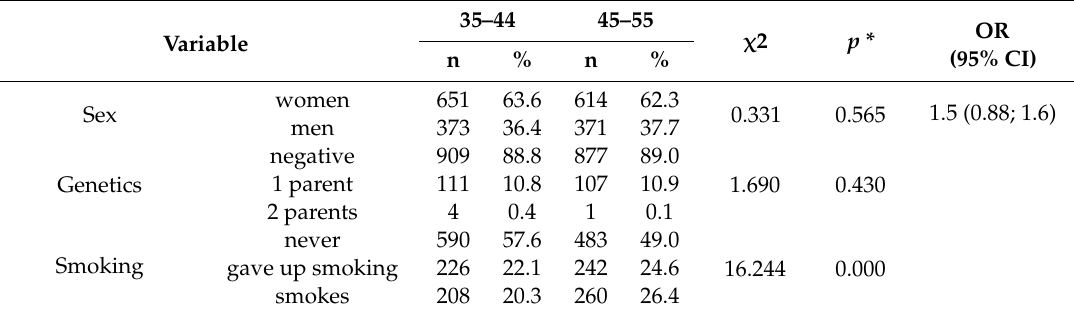
Table 4. Selected parameters with regard to age